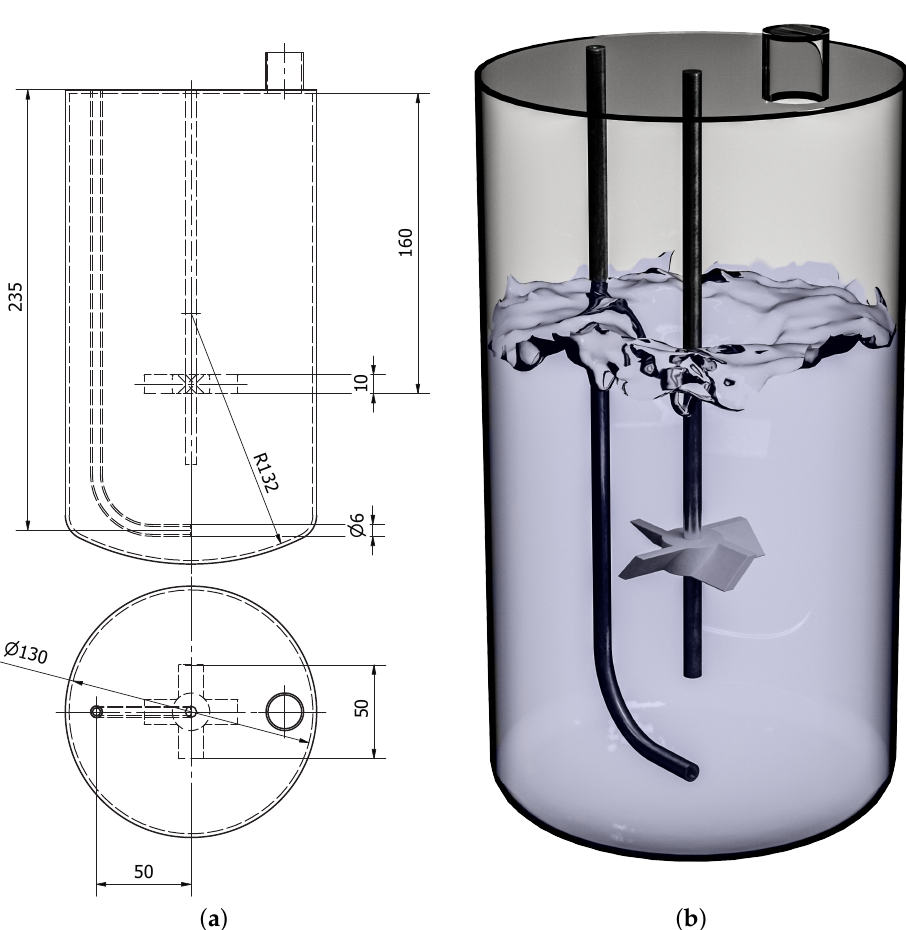
Figure 1. Modified HyPerforma TM glass bioreactor with a pitched four-blade stirrer used for k L a measurements and CFD simulations. ( a ) Technical drawing; ( b ) 3D rendered